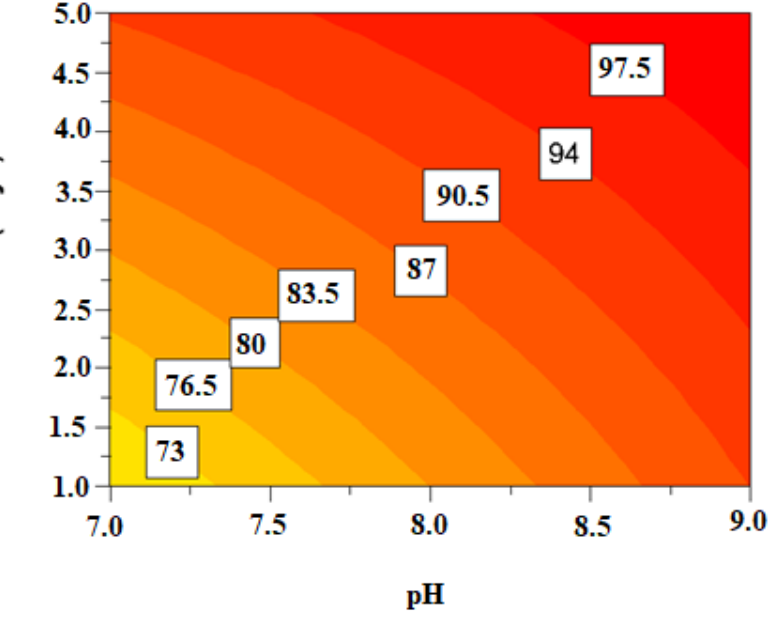
Figure 3. Response surface for the bioremediation process optimization in the function of the variables pH and treatment time with the bacteria forming biofilms (the values on the figure indicate the removal achieved in terms of a percentage).